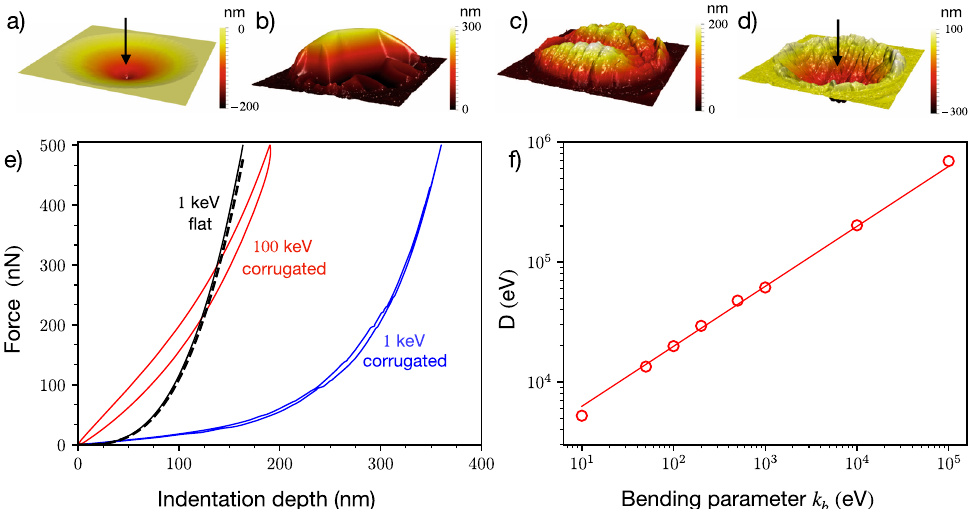
Fig. 4 Simulating indentation by thin-sheet elasticity theory. a Flat membrane over a 3.4-µm-diameter hole with 500 nN force applied in the middle. b Optimized geometry of a membrane with homogeneous and isotropic expansion of ε 0 ¼ 2 : 3 % inferred from the morphology in panel c and using the same morphology as the initial guess. c Morphology of Fig. 1b to which membrane was adapted before indentation simulation (reproduced here for easy comparison); the same morphology was recovered after indentation. d Corrugated membrane at 500 nN force applied in the middle. e Force-indentation curves for fl at membrane with k b = 1 eV (black curve), corrugated membrane with k b = 1 keV (blue curve), and corrugated membrane with k b = 100 keV (red curve). Dashed curve is Eq. (1) with D = 1 keV and E 2D = 336 Nm − 1 . Curves show small hysteresis for corrugated membranes. f Bending moduli D derived from the curves for different bending parameters k b (circles), with a fi t to Eq. (2) (solid line). All images show 3.7 × 3.7 µm area with k b = 1 keV, hole diameter 3.4 µm, and vertical dimension fourfold